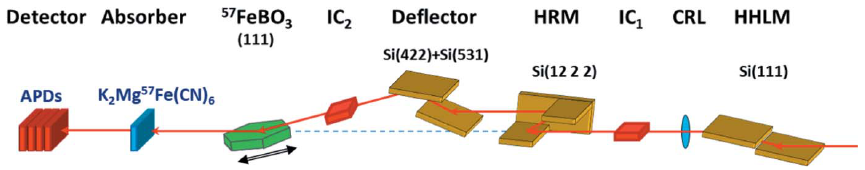
Figure 1 Setup of the experiment. The following abbreviations are used: HHLM – high-heat-load monochromator; CRL – compound refractive lenses; HRM – high-resolution monochromator; APDs – avalance photodiode detectors; IC 1 and IC 2 – ionization chambers. The blue dashed line indicates the path of the beam from the HHLM, emphasizing the ‘in-line’ feature of the